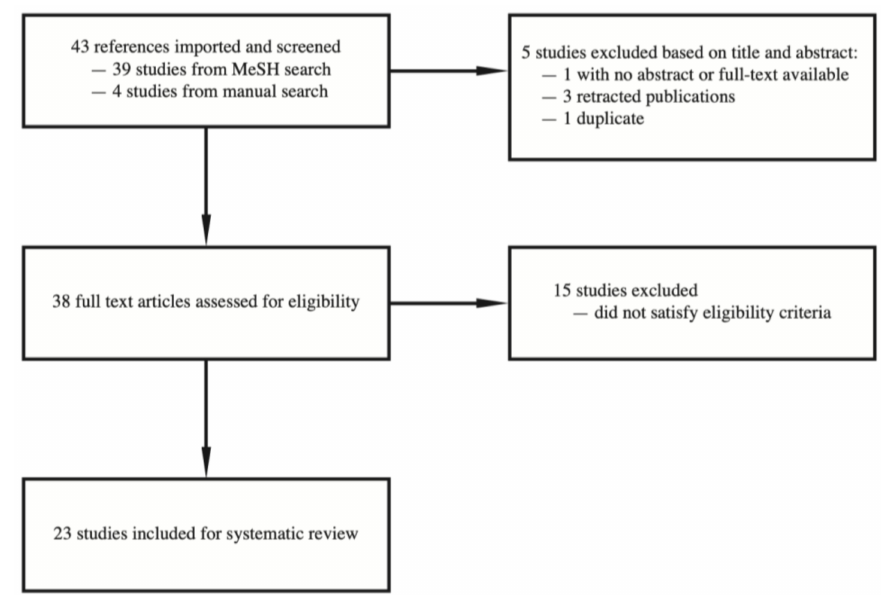
Figure 1. Flow chart of article screening, inclusion, and